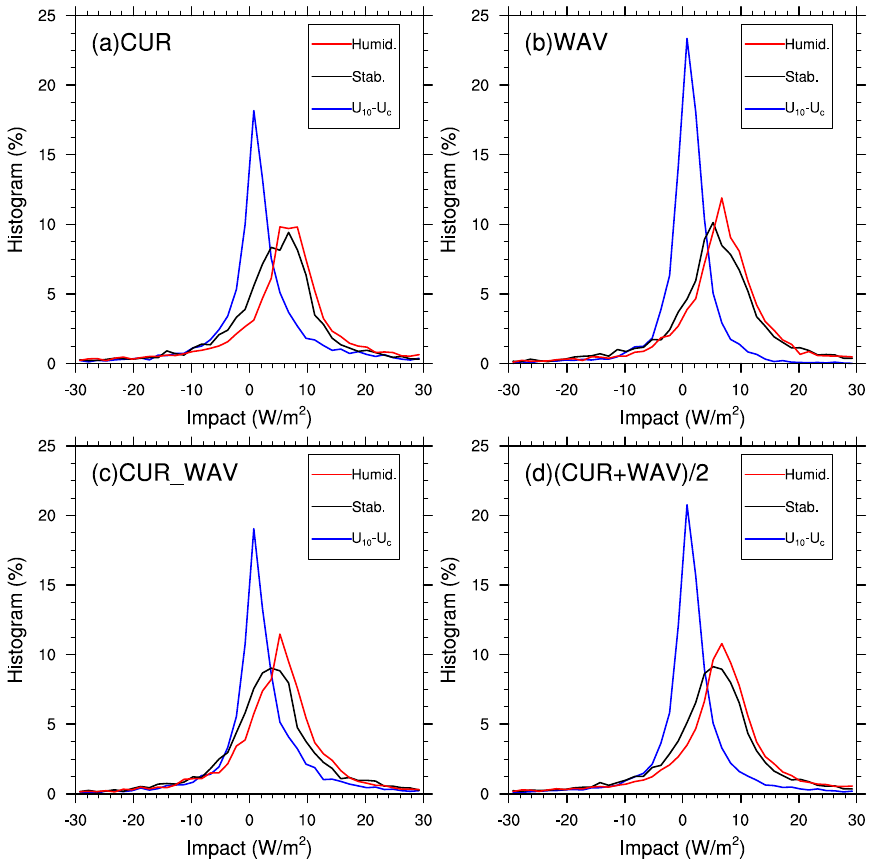
Figure 11. Impact histogram how LHF is changed by surface wind shear, air–sea temperature di ff erences, and humidity di ff erences for ( a ) CUR, ( b ) WAV, ( c ) CUR_WAV, and ( d ) the average of CUR and WAV.